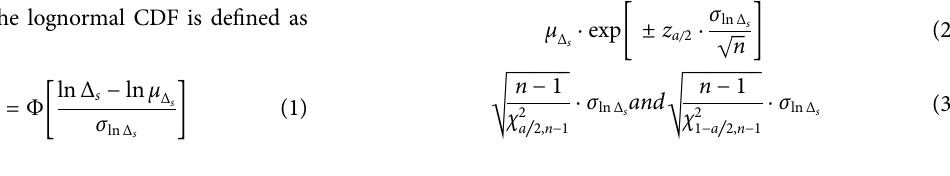
Frontiers in Built Environment |